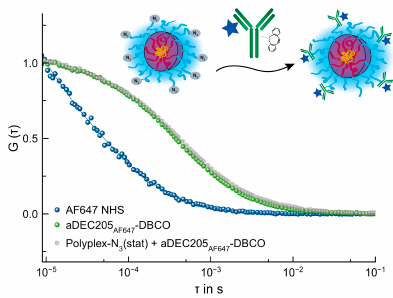
Figure 7. FCS: SPAAC of polyplex by P(Lys)- b -P(HPMA)-N 3 (stat) and aDEC205 AF647 -DBCO: blue line: AF647 NHS: R h = 0.76 nm; green line: aDEC205 AF647 -DBCO: R h = 5.5 nm; conjugate of aDEC205-DBCO and polyplex by P(Lys)- b -P(HPMA)-N 3 (stat): R h = 52 nm (5%).